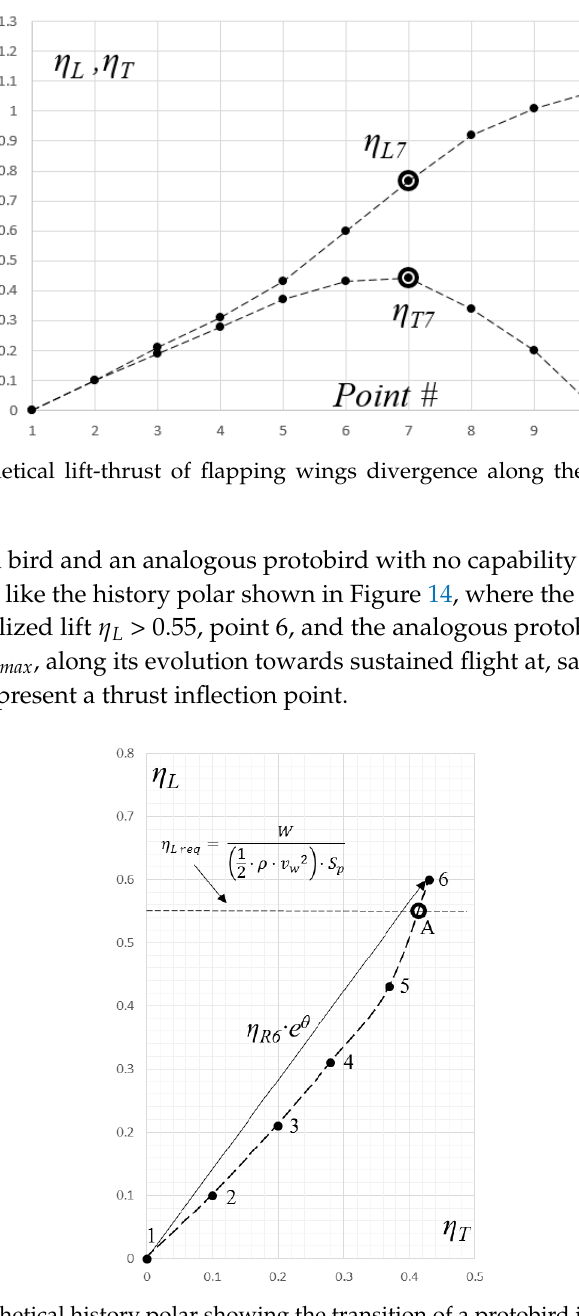
Figure 14. A hypothetical history polar showing the transition of a protobird into a bird at point A.